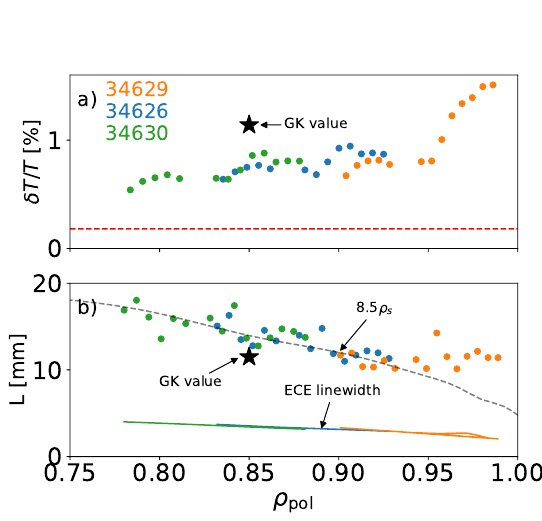
Figure 3. High radial resolution δ T e , ⊥ / T e profile (a) and correla- tion length profile, L r ( T e ⊥ ), (b) as measured by the AUG CECE diagnostic. L r ( T e ⊥ ) is shown to agree well with 8.5 ρ s in this case, with a jump at ρ pol = 0 . 95. The ECE linewidth w ECE and gyroki- netic values are also shown for